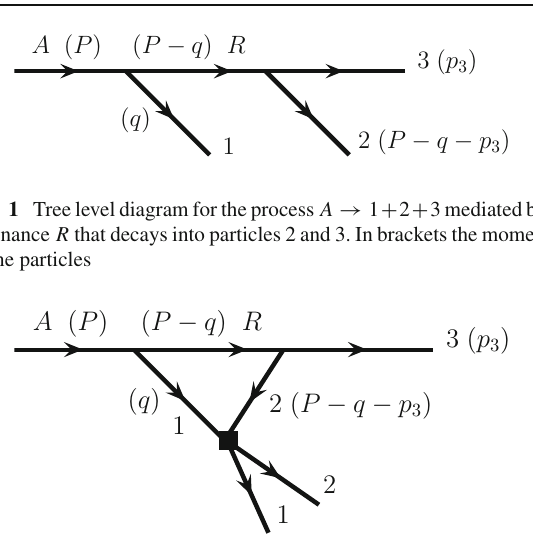
Fig. 2 Triangle mechanism emerging from the mechanism of Fig. 1, with final state interaction of particles 1 and 2. In brackets the momenta of the